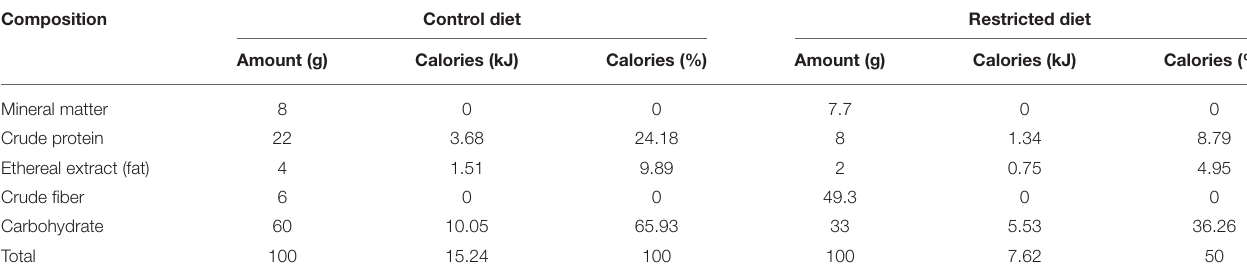
TABLE 1 | Composition of experimental diets.